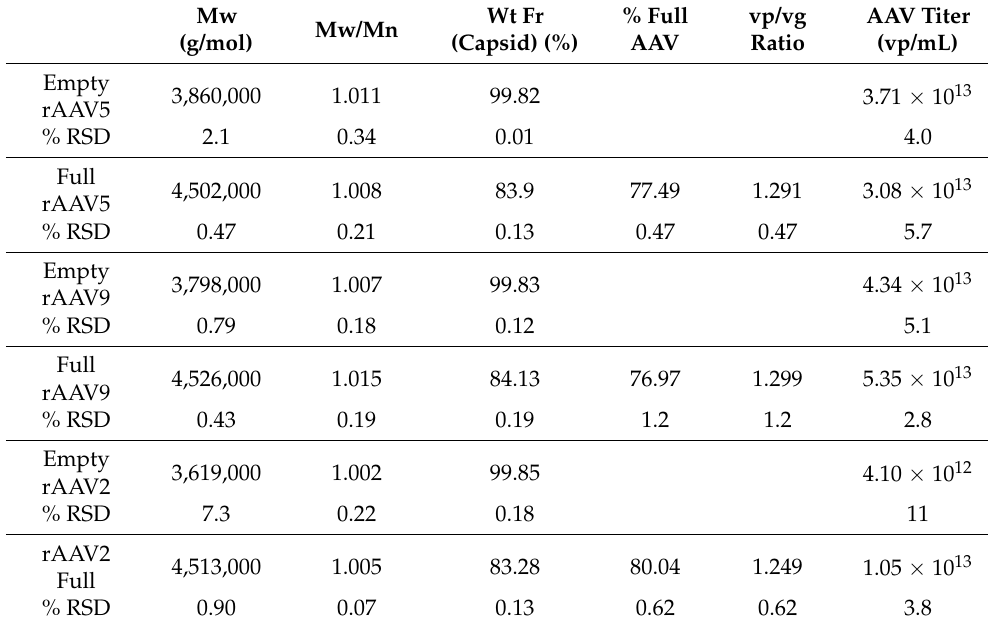
Table 7. Quantitative parameters for monomers in each the Empty rAAV5, Full rAAV5, Empty rAAV9, Full rAAV9, Empty rAAV2 and Full rAAV2 samples and the percentage relative standard deviations of the results.